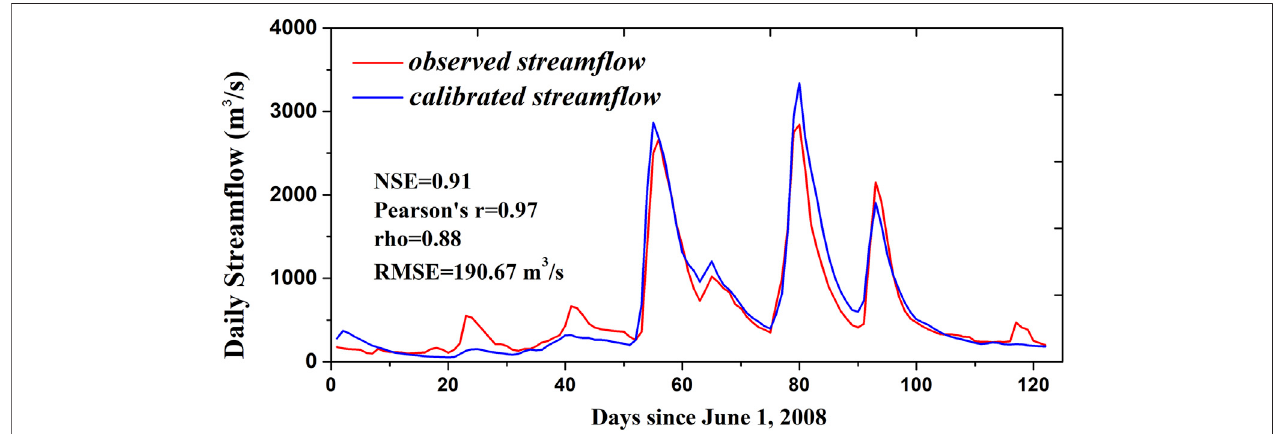
FIGURE 3 | Comparison of the observed and calibrated stream fl ow in the WJB sub-basin from June to September 2008.